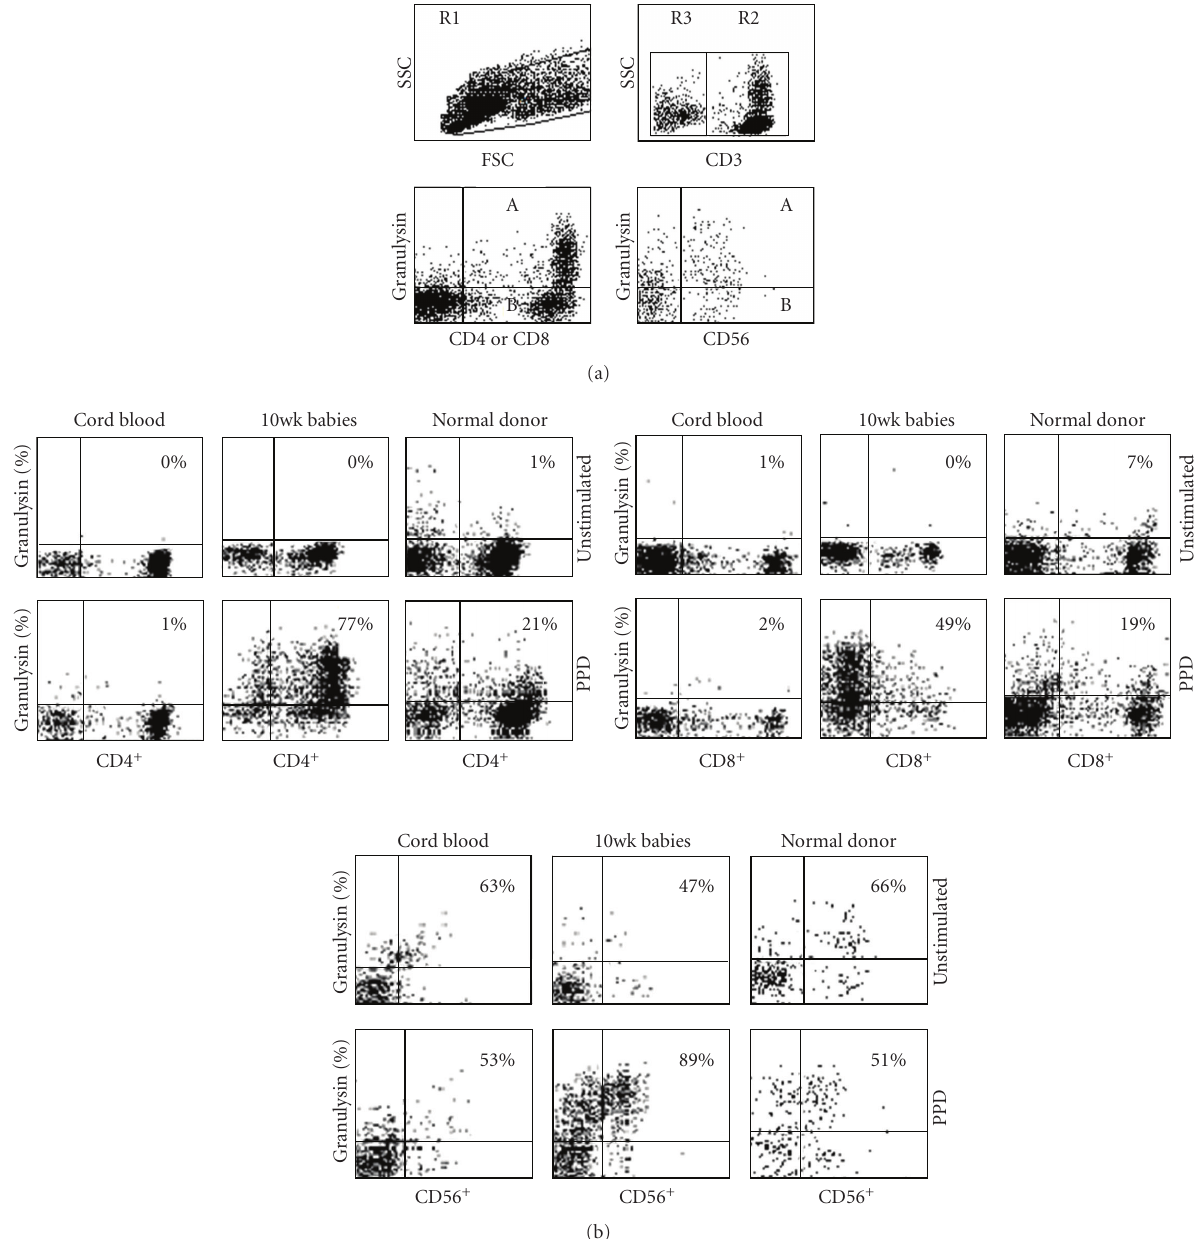
Figure 1: (a) Flow cytometric diagram illustrating the gating strategy for the expression of granulysin (or Perforin) in T-cells and NK cells. R1 represents a general lymphocyte gate including all lymphocytes in a PPD stimulated PBMC sample. R2 incorporates all CD3 + T-cells within the R1 gate, and R3 includes all cells that are CD3 − . Percentage cells expressing granulysin (represented on the y-axis) are evaluated by dividing the number of cells in A by the number of cells in A + B × 100. (b) Flow cytometric dotplots of granulysin in unstimulated or PPD-stimulated representative samples of cord blood mononuclear cells in the left column, 10-week-old infants after BCG vaccination in the middle column, and PBMC from healthy PPD + adult volunteers in the right column. Results shown represent T-lymphocytes which are CD4 + /CD3 + or CD8 + /CD3 + or NK cells which are CD56 + /CD3 − . See Section 2 for